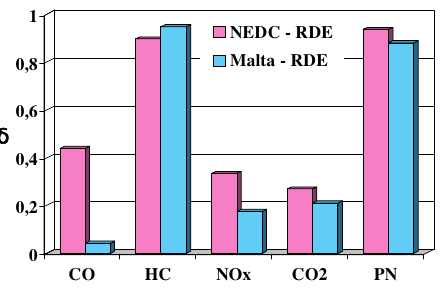
Fig. 22. Relative difference of the mean road emission of individual ga- seous pollutants and the mean particle number– d for the NEDC test and the modeled values from the RDE test, as well as for the Malta test and the modeled values from the RDE test